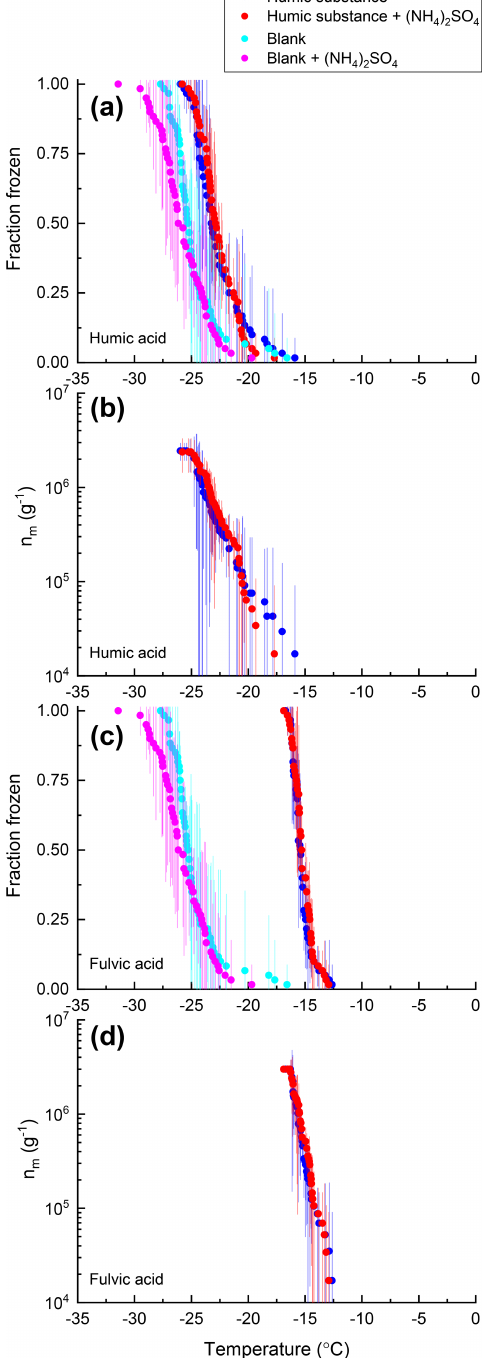
Figure 6. Fraction of droplets frozen (a, c) and the concentra- tion of INSs per liter of solution [INS( T )] (b, d) for samples of the Arctic sea surface microlayer from station 2 (a, b) and sta- tion 7 (c, d) with (red) and without (blue) 0.05M(NH 4 ) 2 SO 4 com- pared with an ultrapure water blank with (pink) and without (cyan) 0.05M(NH 4 ) 2 SO 4 . Freezing data (both samples and blanks) have been corrected for freezing point depression by 0.05M(NH 4 ) 2 SO 4 . Error bars represent the 95% confidence interval of fraction frozen or [INS( T )] at temperature T calculated using Student’s t distribu- tion.